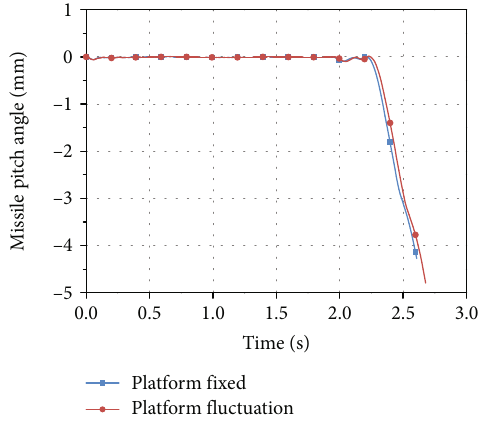
Figure 20: Missile derailment speed under two